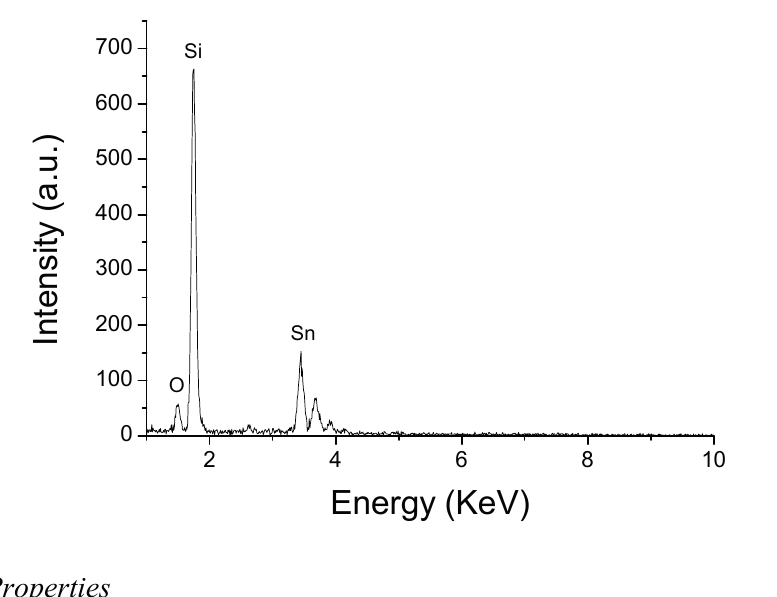
Figure 6. EDX spectrogram of the SnO 2 nanofiber